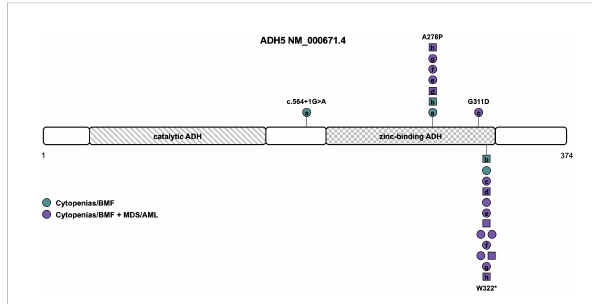
FIGURE 4 Schematic of the ADH5 transcript (NM_000671.4) and its protein domains with the location of all reported germline variants. Circles represent females and squares represent males. Symbols on the same horizontal level are individuals from the same family. Letters within the symbols indicate individuals with compound heterozygous genotype, while symbols without letters indicate homozygosity for the variant. The color fi ll depicts different phenotypes. ADH, alcohol dehydrogenase; AML, acute myeloid leukemia; BMF, bone marrow failure; MDS, myelodysplastic